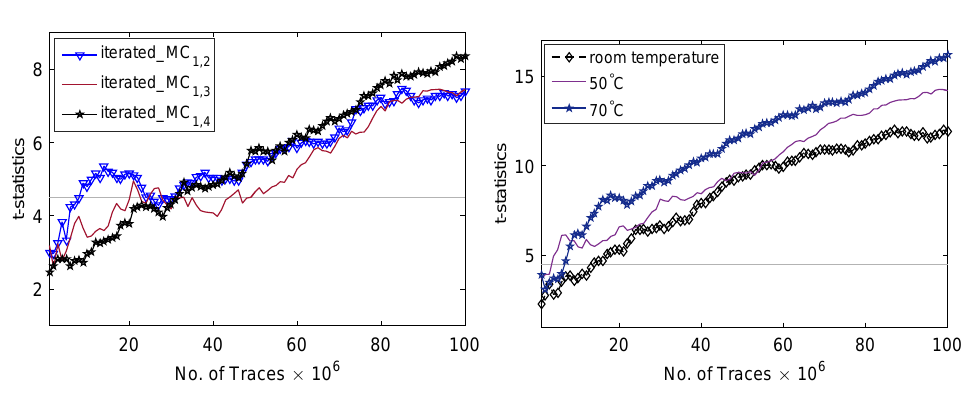
Figure 7: Case study 1: 2 shares, shunt 0.0 Ω, 3 MC modules, clock 6 MHz, max ( | t | ) 1st-order, over the number of